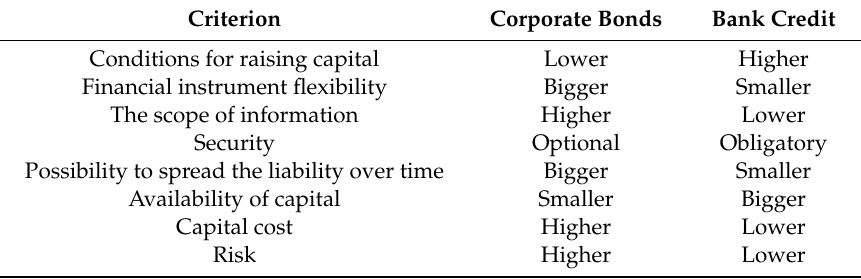
Table 1. Corporate bonds and bank